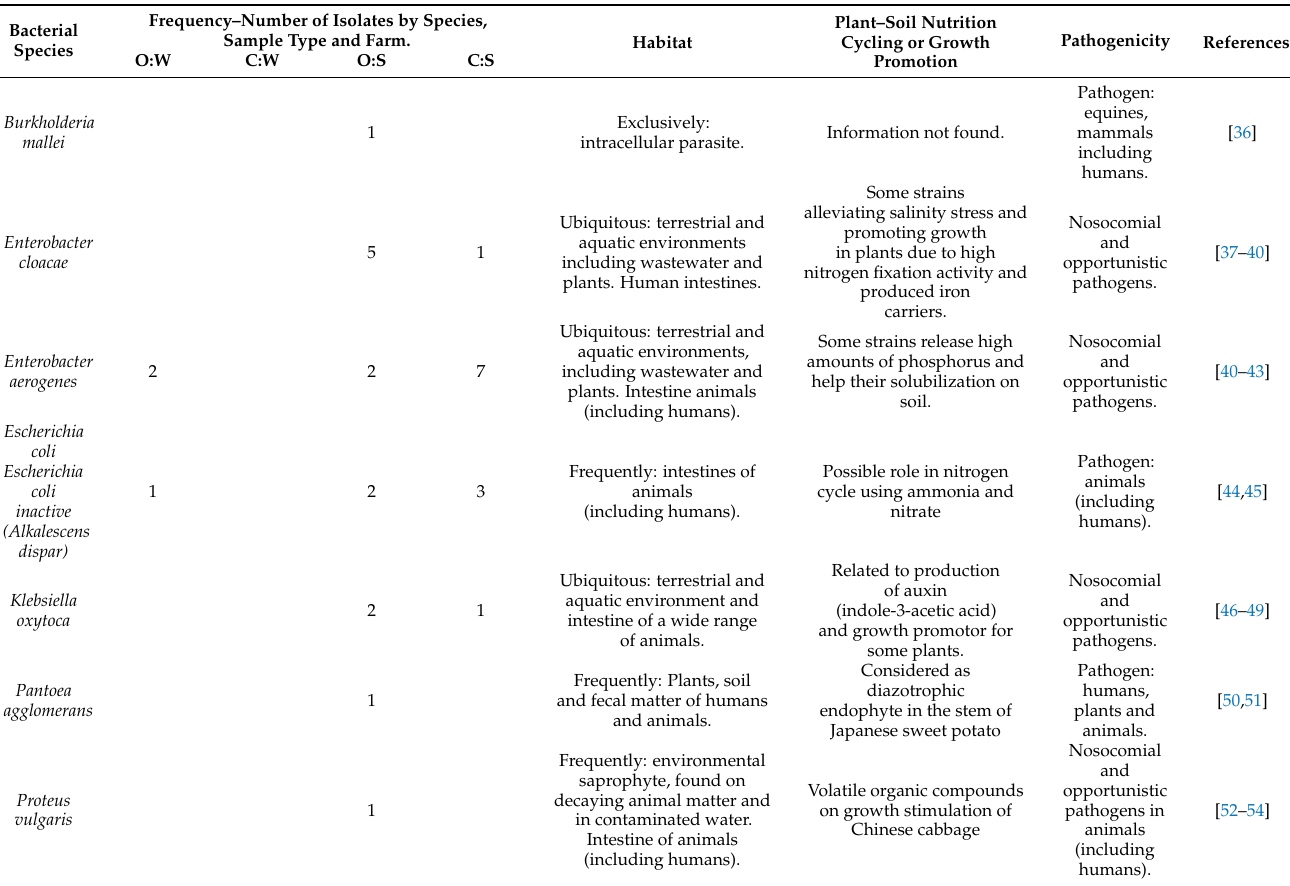
Table 2. Gram-negative bacteria species isolated from water and soil samples for the two farm types and their ecology and pathogenicity based on literature. Frequency–Number of Isolates by Species, Bacterial Sample Type and Species